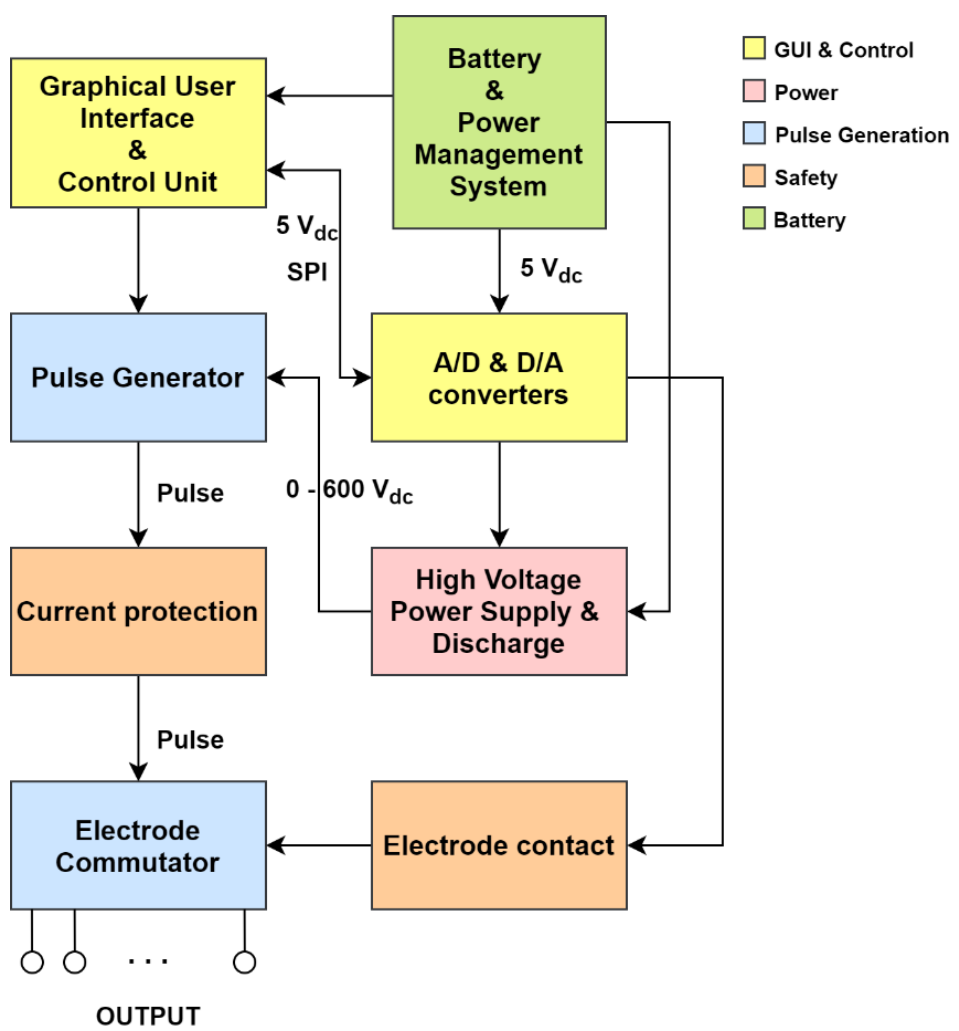
Figure 2. Block diagram of the device for GET to skin cells.